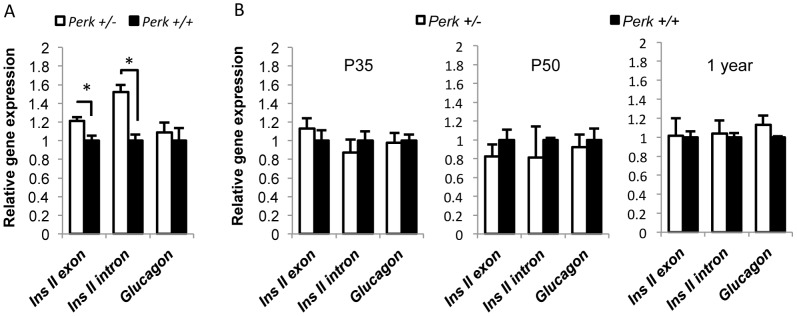
Insulin transcription was up-regulated in P17 Perk+/− mice.A. Gene expression levels of mouse islets relative to Perk+/+. Mice are postnatal 17 days. Shown are means ± SEM. (n for Perk +/−, Perk+/+  = 11,9. *P<0.05). B. Gene expression level of mouse islets relative to Perk+/+. Islets were isolated from mice at various ages as indicated. Shown are means ± SEM. (n for Perk +/−, Perk+/+  =  8, 8 (P35); 3, 4 (P50); 6, 6(1 year). No significant difference was seen for any gene at any age).